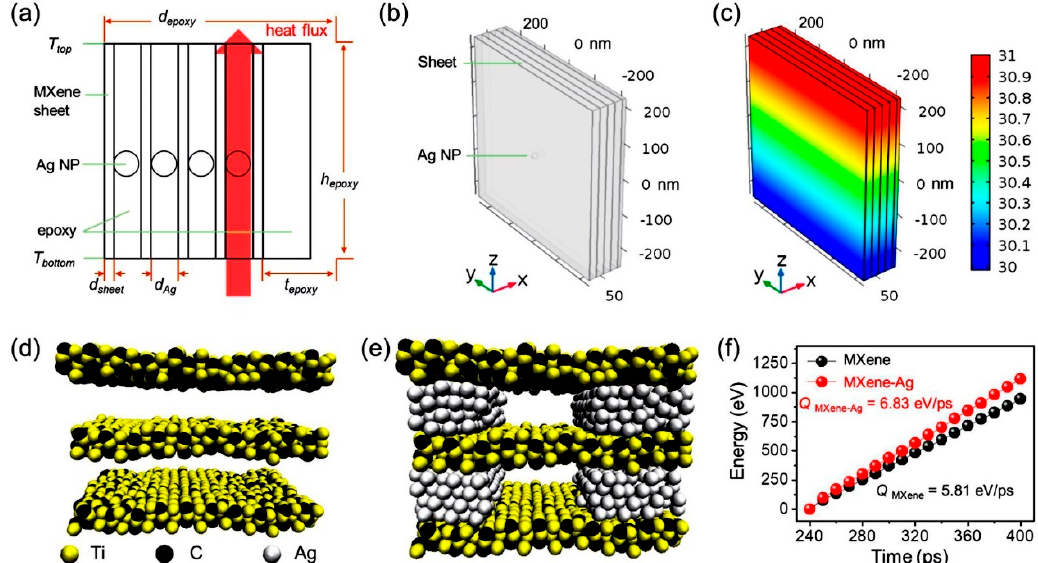
Figure 24. ( a ) Schematic of simulation model. ( b ) Simulation model with MXene sheets and Ag NPs. ( c ) Temperature distribution of simulation model with MXene/Ag. Schematic of multilayered ( d ) Mxene and ( e ) MXene-Ag. ( f ) Energy injected into (removing from) the heat sink (source) varies with time (reproduced with permission from [165]).